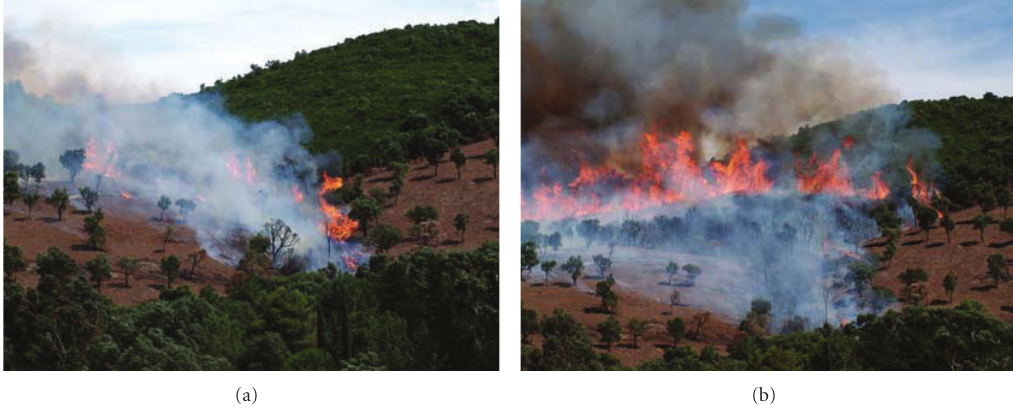
Figure 4: Ignition point and subsequent spreading.